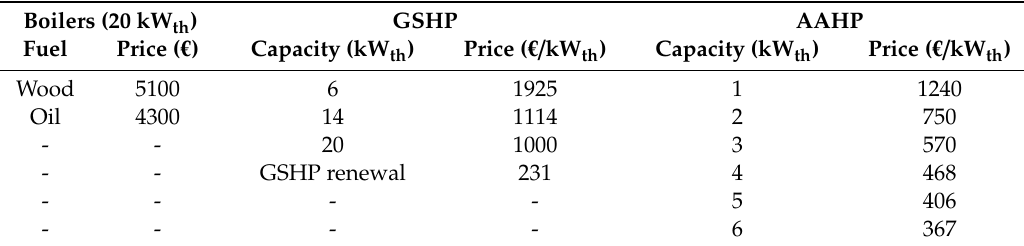
Table 6. Cost of heating devices (with installation). [57].